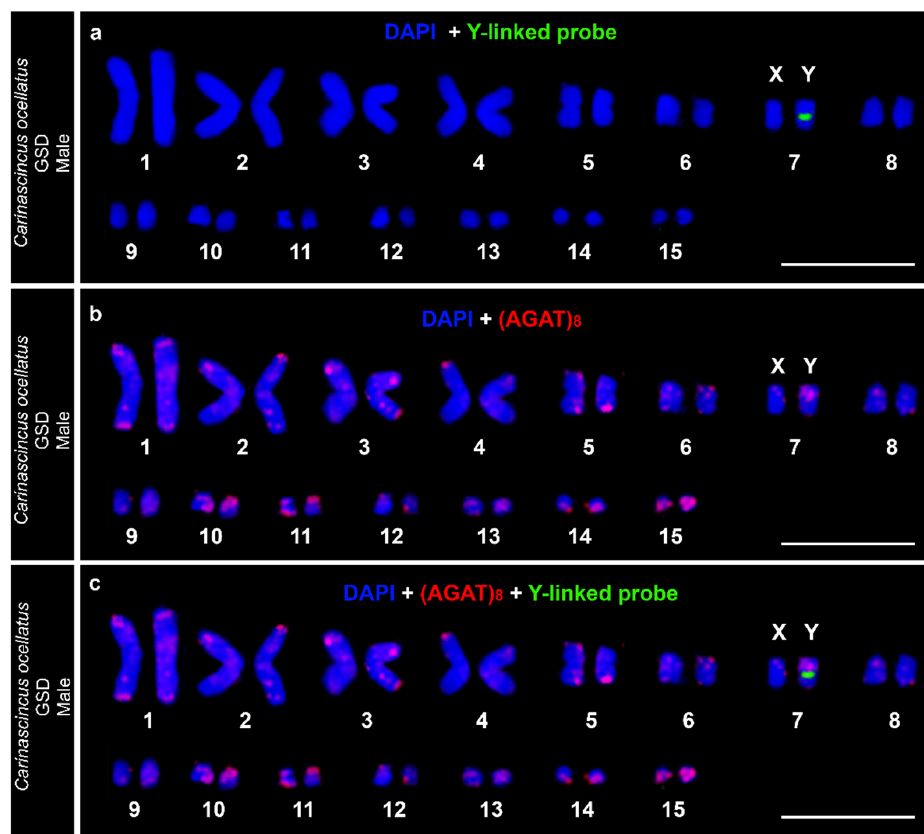
Figure 8. Sequential FISH and karyotyping in GSD (high elevation) population of Carinascincus ocellatus to confirm chromosome seven as the sex chromosome pair. ( a ) DAPI stained karyotype with FISH signals from Y-linked probe set (Pseudocoloured green) on C. ocellatus male; ( b ) DAPI stained karyotype with FISH signals from (AGAT) 8 microsatellite probe (red) on the same metaphase; ( c ) Superimposed image of both layers indicates (AGAT) 8 rich Y chromosome.